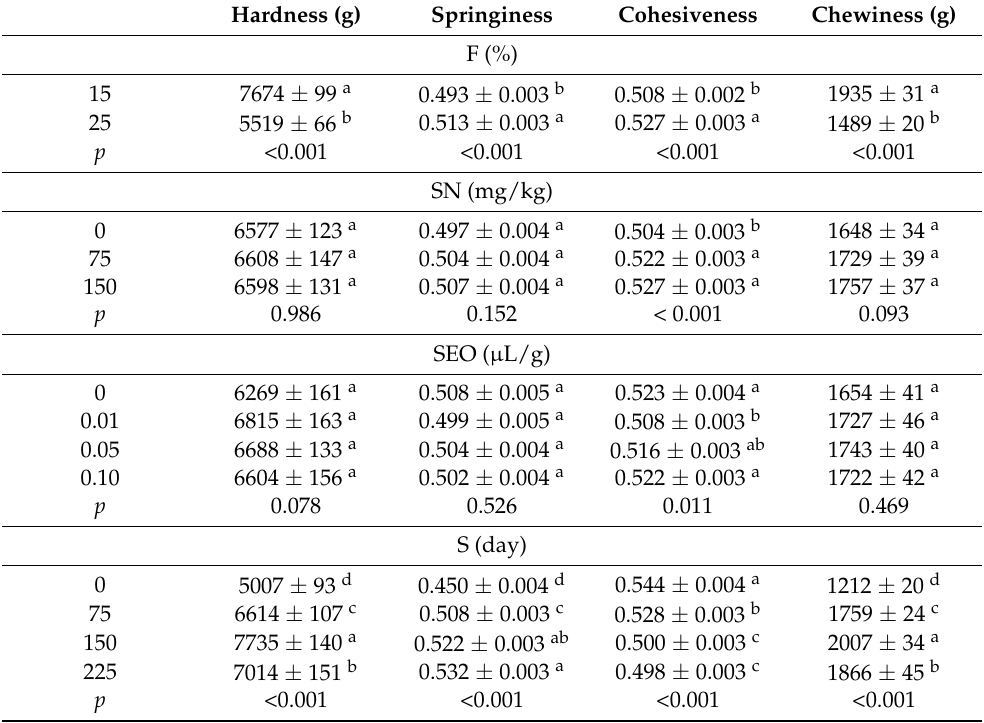
Table 6. Instrumental texture parameters of